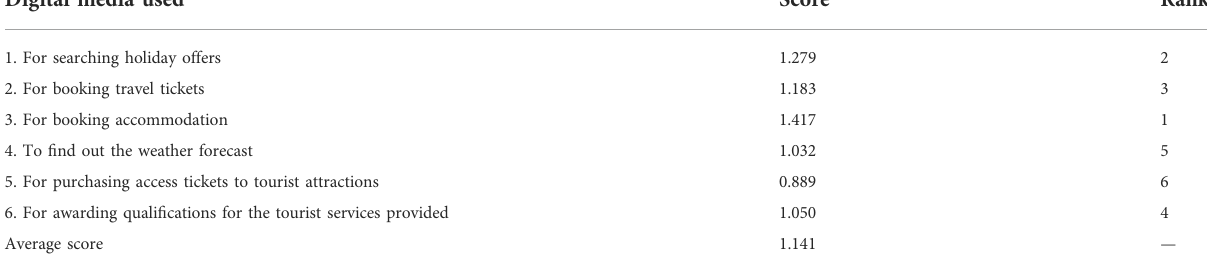
TABLE 9 Scores on why digital media is used to plan a holiday at an ecotourism destination. Digital media